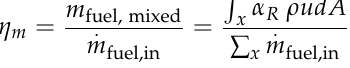
Figure 8. Comparison of streamwise vortex magnitudes downstream of the pylon for three different air temperatures.